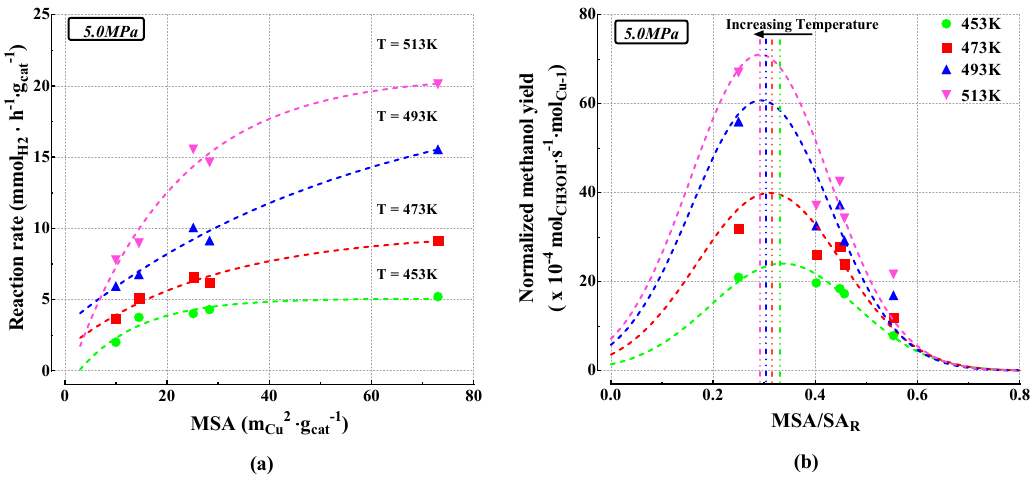
Figure 5. Structure-reactivity relationships for Cu-ZnO catalysts: ( a ) Reaction rate as function of MSA at 5.0 MPa; ( b ) Normalized methanol yield vs. MSA/SA R at 5.0 MPa.